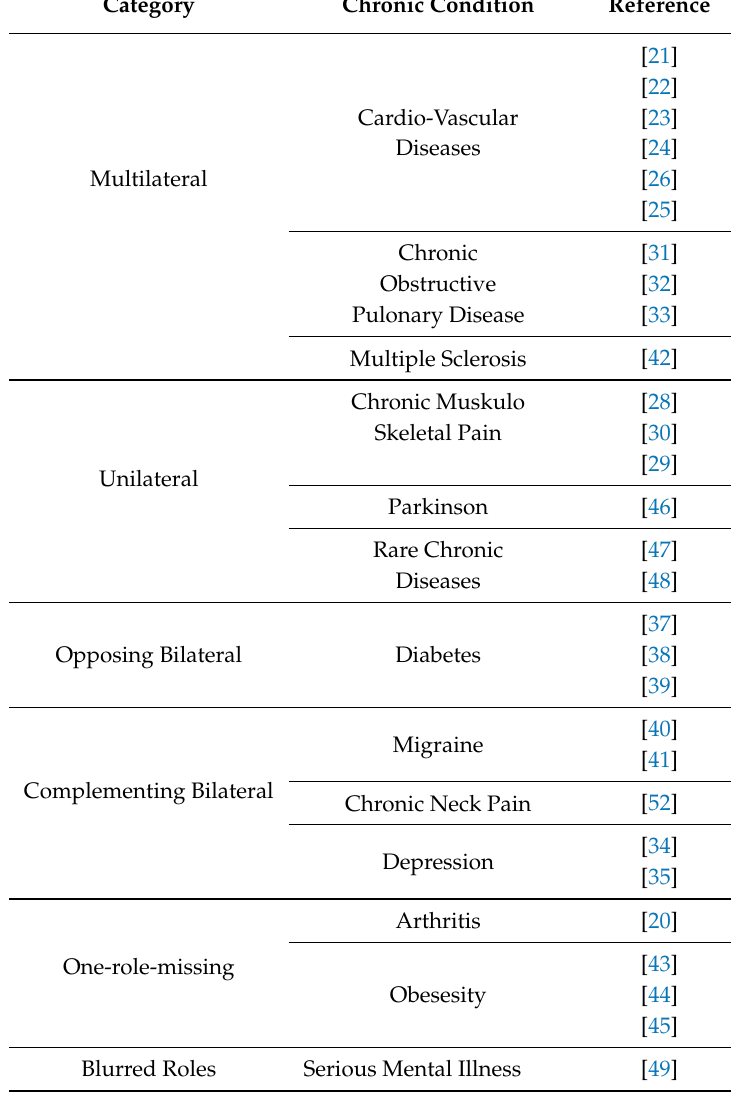
Table 4 summarizes the results and findings for the HCSs and their configuration categories. Table 4. Summary of the category results along with their figures and reference